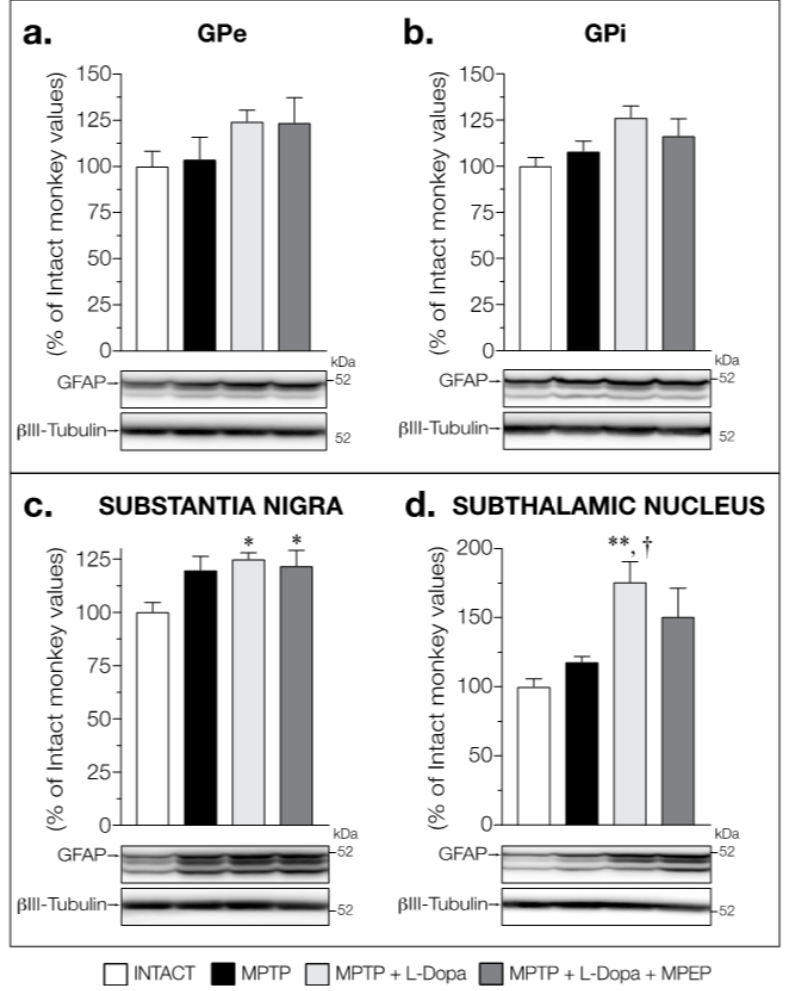
Figure 4. Western blots for GFAP protein levels in ( a ) GPe, ( b ) GPi, ( c ) substantia nigra , and ( d ) subthalamic nucleus of intact monkeys (control), MPTP monkeys treated with saline, L-Dopa, and L-Dopa + MPEP. Values are means of arbitrary units expressed as percentage of control ( β III-tubulin was used as internal loading control) of 2 – 4 independent experiments ± standard error of mean of 4 – 5 monkeys per group. * p < 0.05 and ** p < 0.01 vs. INTACT; † p < 0.05 vs. MPTP.